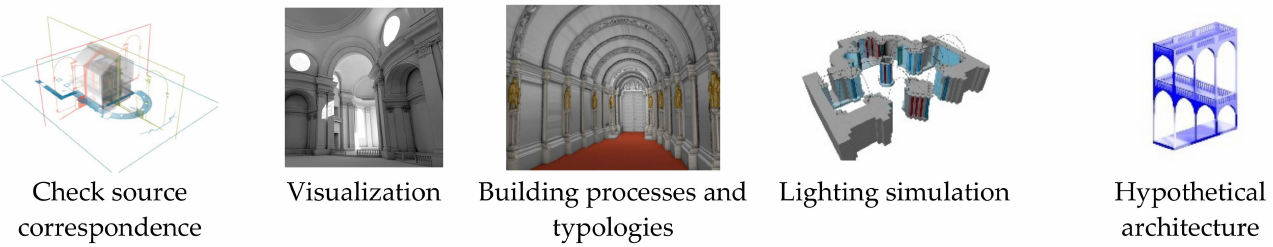
Figure 4. Example research applications of 3D models in architectural history